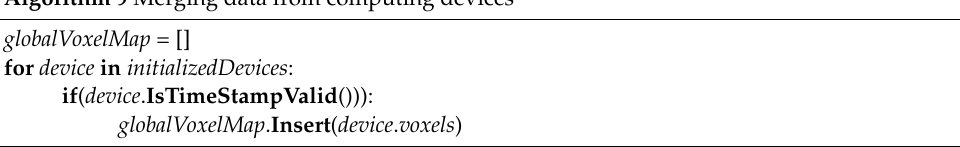
Algorithm 9 Merging data from computing